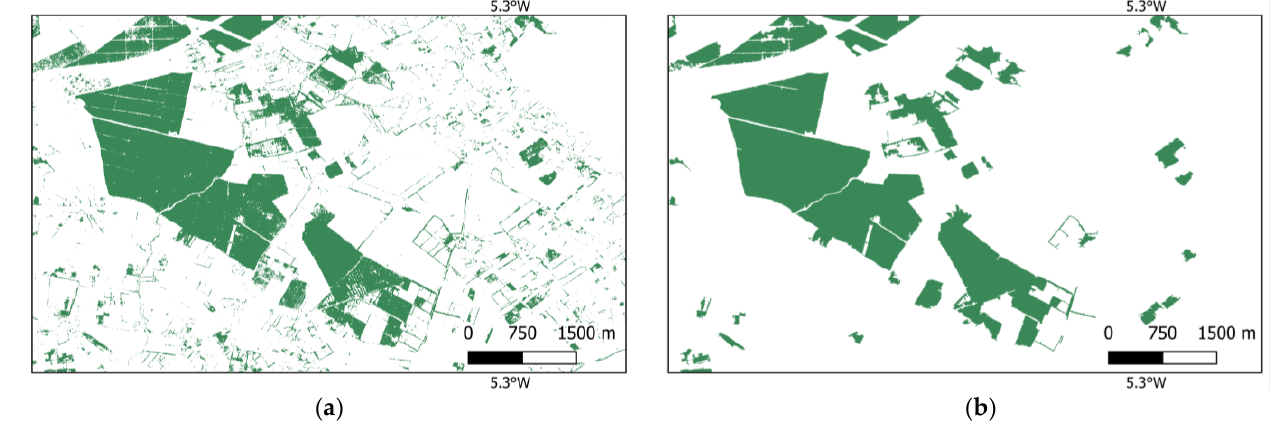
Figure 16. Post-processing the clustered area using the GDAL Sieve tool [64] in QGIS (version Białowieża) with a threshold of 500 px: ( a ) the raw result from the clustering sequence (NDVI + NIR); ( b ) the sieved data. Table 8. Commission errors after “sieving” at a 500-pixel threshold using NDVI and MSAVI-2. Commission Errors